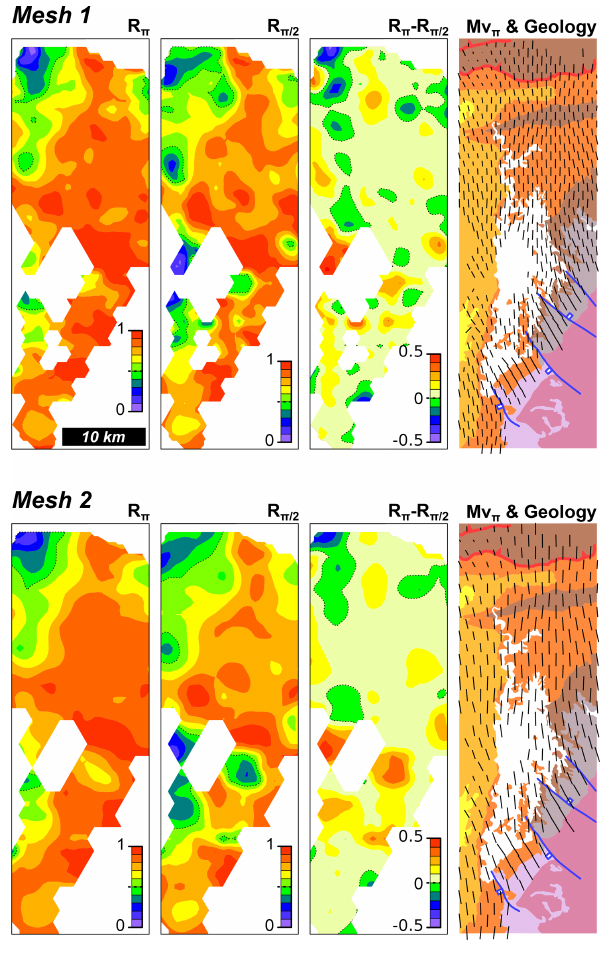
Figure 5. Results of circular statistics analysis for both meshes 1 and 2. Length of traces of Mv π is proportional to R π . Color code refers to R π and R π/ 2 , whereas the orientation of traces is the Mv. See text for